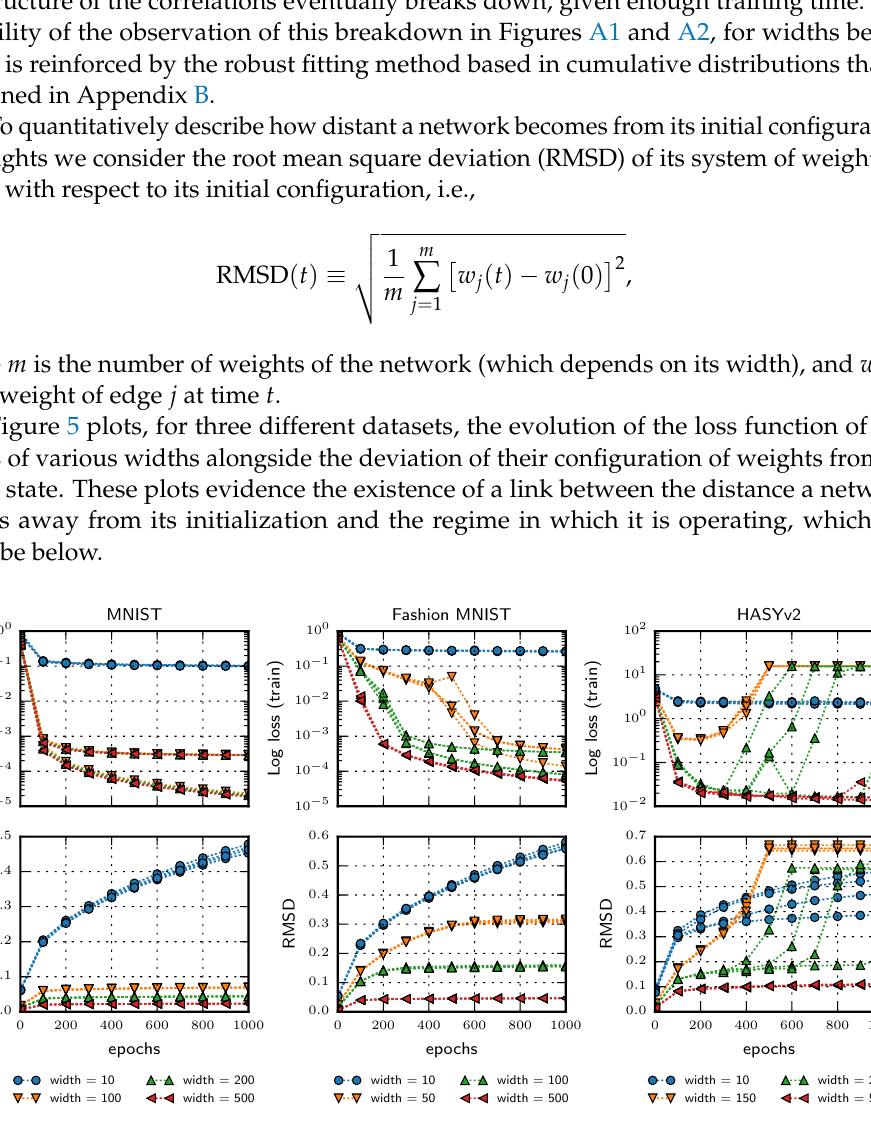
Figure 5. Top: Temporal evolution of the loss function of networks of various widths. Bottom: Evolution of the root mean square deviation (RMSD) between the initial configuration of weights of a network and its current configuration. From left to right: networks trained on the MNIST, Fashion MNIST, and HASYv2 datasets. Five independent test runs are plotted (individually) for each value of width and each